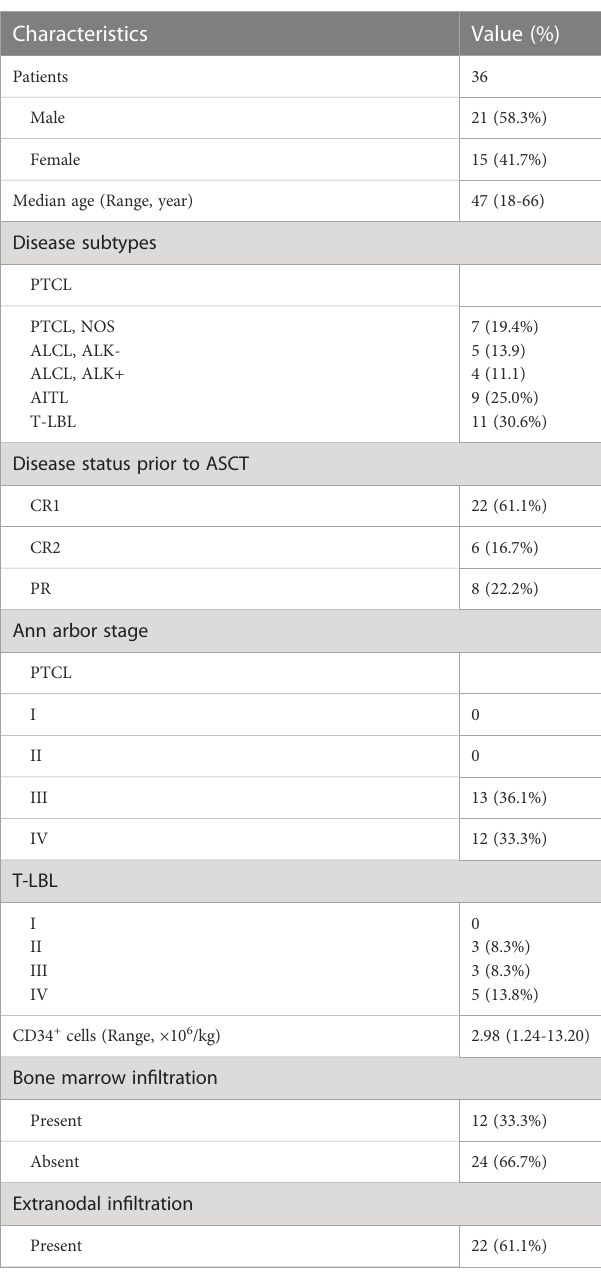
TABLE 2 Characteristics of included patients.